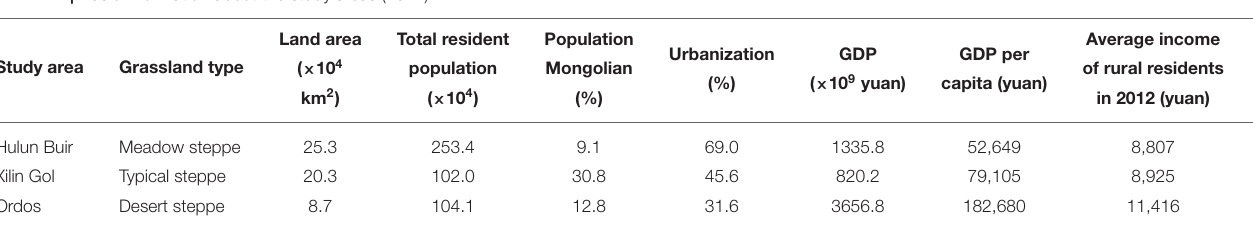
TABLE 1 | Basic information about the study areas